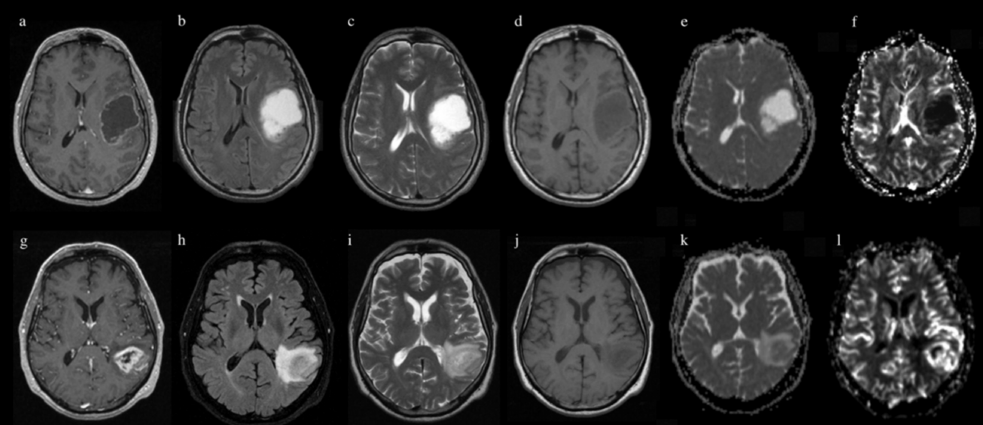
Figure 5. Examples of correctly predicted outcome (IDH mutation) from our CNN model. Images above show MPRAGE ( a ), FLAIR ( b ), T2 ( c ), T1 ( d ), ADC ( e ) and rCBV ( f ) sequences of a patient with IDH mutated GBM. Images below show MPRAGE ( g ), FLAIR ( h ), T2 ( i ), T1 ( j ) ADC ( k ) and rCBV ( l ) sequences of a patient with IDH-wild-type